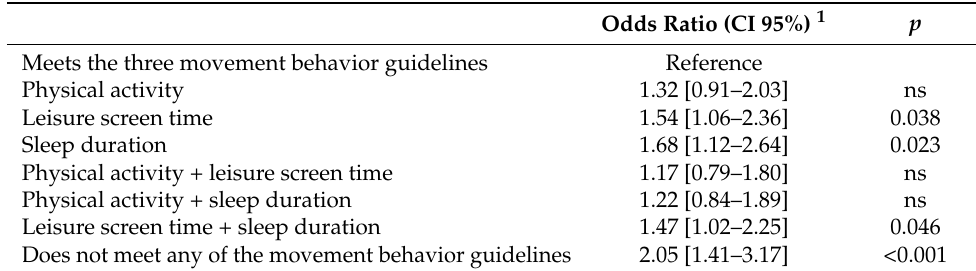
Table 4. The chance of adolescents presenting a higher continuous risk score for cardiometabolic health associated with the guidelines of healthy movement behaviors (physical activity, recreational screen time, and sleep